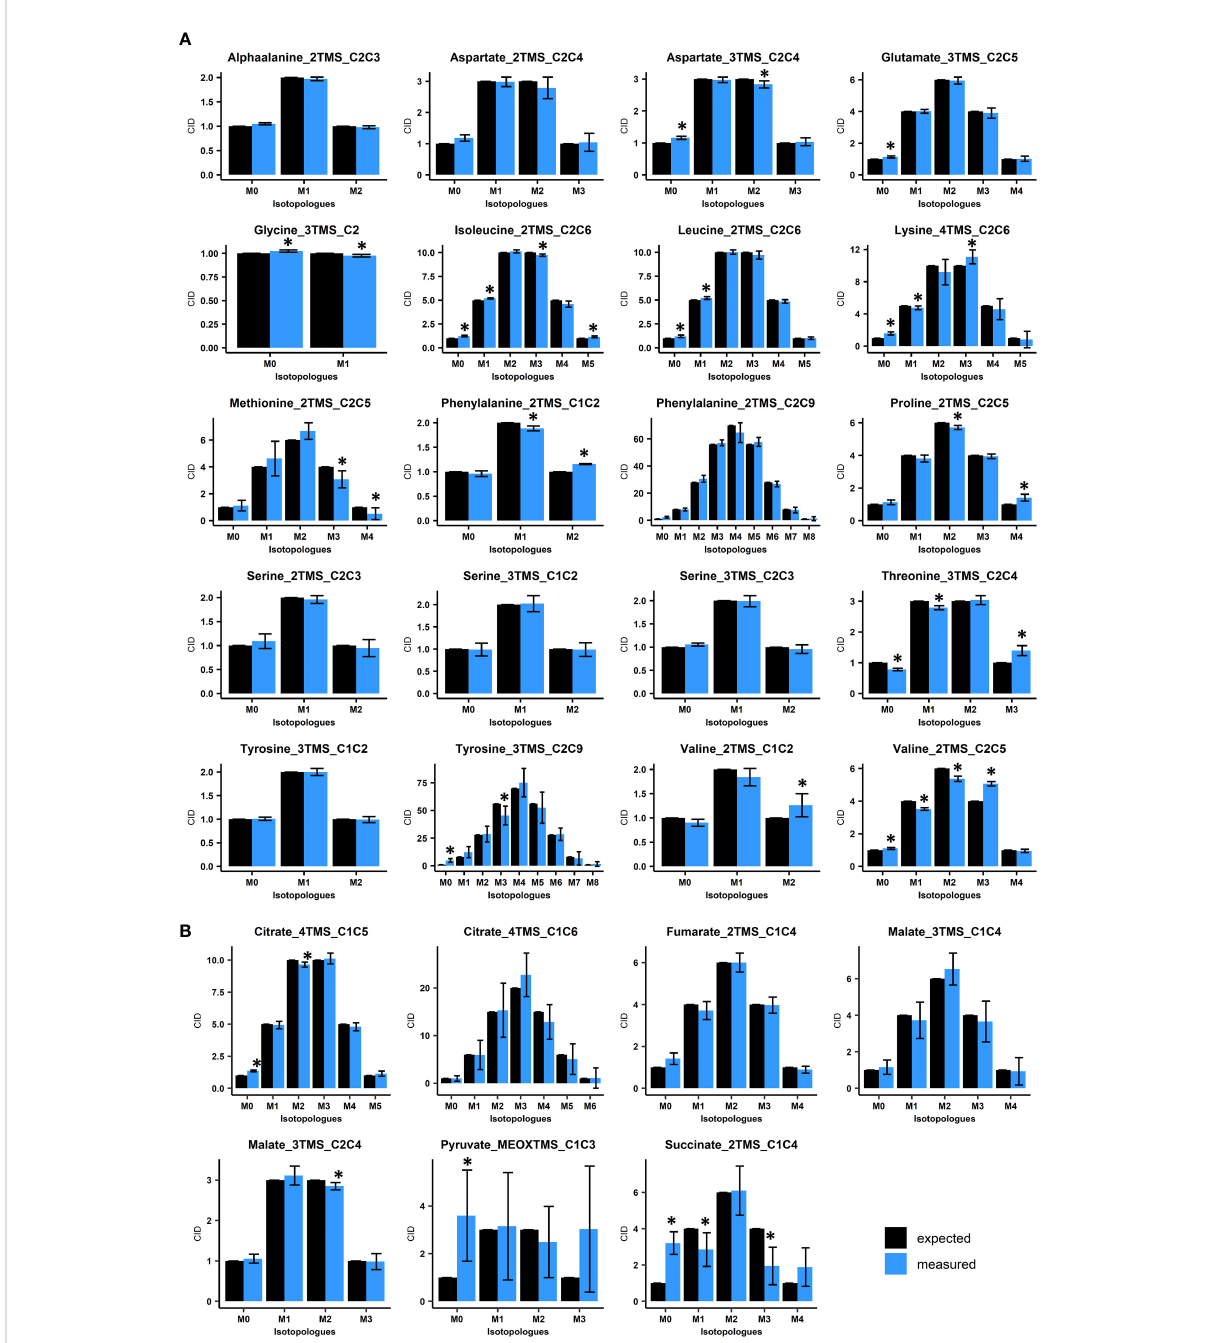
FIGURE 2 Evaluation of Carbon Isotopologue Distribution (CID) measurements for organic and amino acids by GC-MS using 13 C-PT reference samples. (A) , Evaluation of amino acids using 13 C-PT protein hydrolysates. (B) , Evaluation of organic acids using 13 C-PT full metabolites extracts. Black bars correspond to expected CIDs and blue bars to the measured CIDs. The results are presented as the mean ± SD of four independent biological replicates. Statistical differences between predicted and measured CID for each isotopologue of each fragment are denoted with asterisks (*) and were established by considering the 95% con fi dence intervals of the measured CID. GC-MS fragments are denoted according to the considered metabolite, its MEOX/TMS-derivatives analyzed and the metabolite carbon backbone [for example, Glutamate_3TMS_C2C5 means that the fragment comes from glutamate(3TMS) and contains the carbon C2-C3-C4-C5 (Table